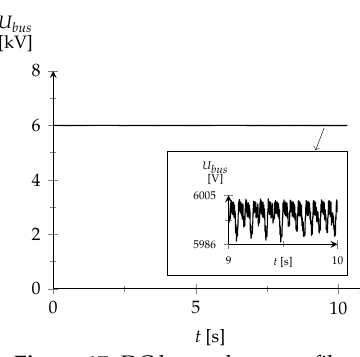
Figure 17. DC bus voltage